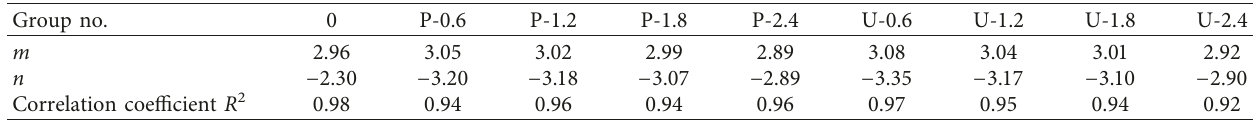
Figure 12: Stress-strain curves of various groups of fiber Table 4: values of m and n as obtained from Equation (9).